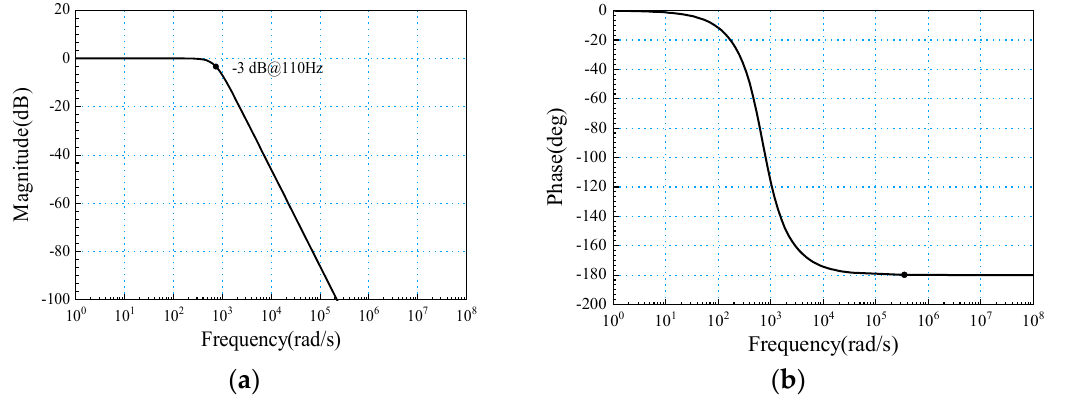
Figure 12. Speed loop closed-loop Bode diagram. ( a ) Amplitude diagram. ( b ) The phase diagram.